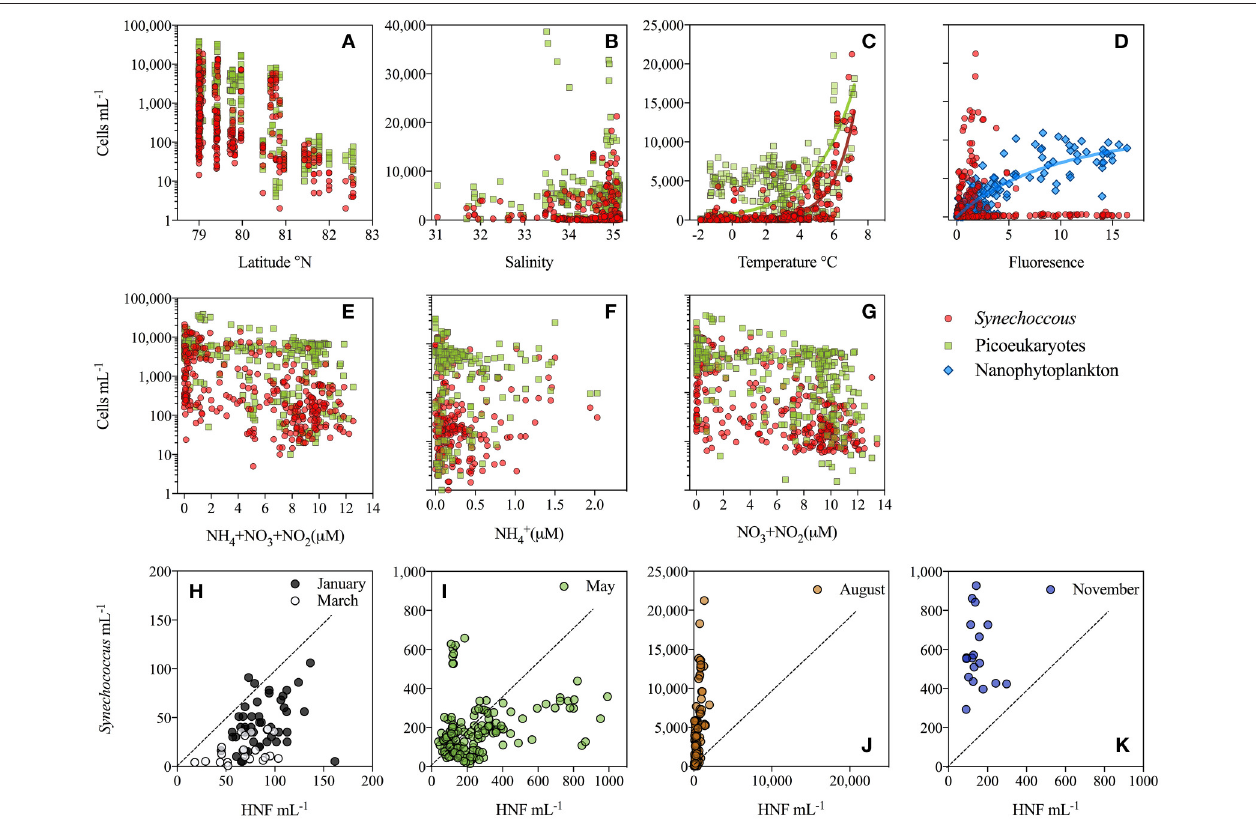
FIGURE 5 | (Two upper panels) Data collected within upper 100m from all cruises plotted to see how abundance of Synechococcus (red) relates to environmental parameters, such as (A) latitude (B) salinity (C) temperature (D) chlorophyll fluorescence and (E–G) concentration of different sources of mineral nitrogen. Additionally (A,B,E–G) contain abundance of picoeukaryotes (green) and (D) nanophytoplankton (blue). Notice log-scale for (A,B,E–G) . (Lower panel) (H–K) Synechococcus abundance (mL − 1 ) plotted against HNF abundance during the different months (indicated by color) within the upper 200 m. The broken line illustrates the one-to-one line. Notice different y-axis between months. Only samples with Synechococcus abundance > 20 cells mL − 1 were